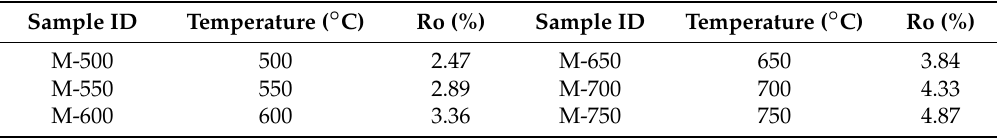
Table 3. Vitrinite reflectance values of shale samples at different simulation